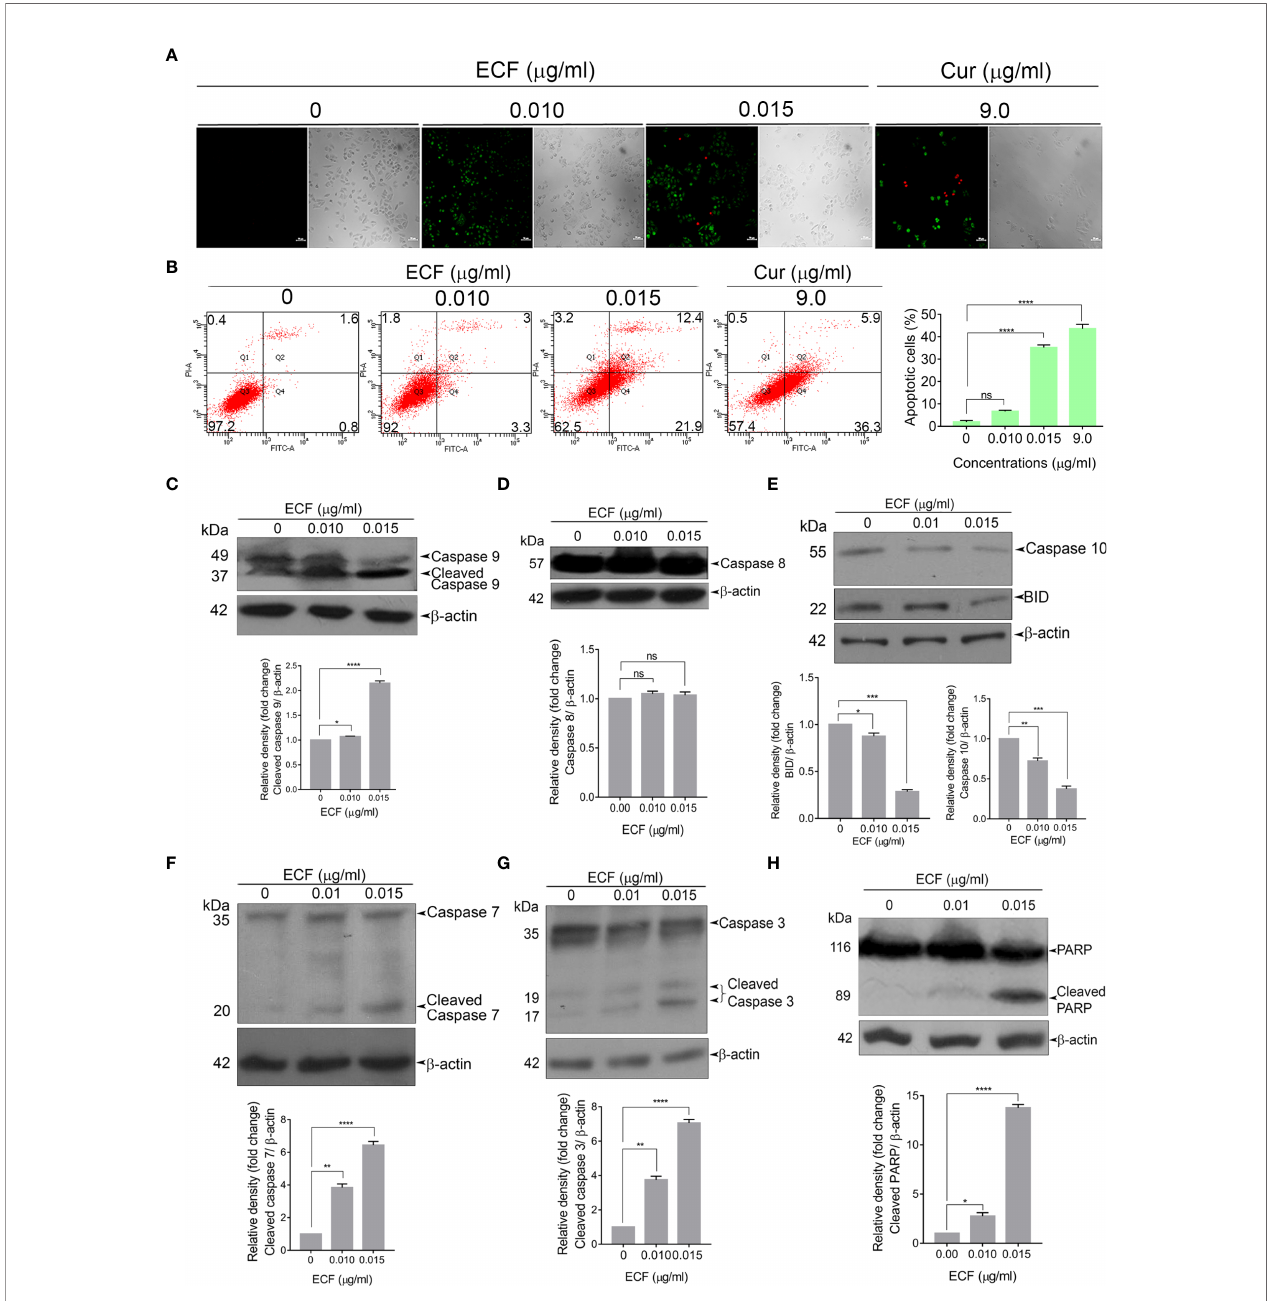
FIGURE 2 | ECF triggers apoptotic mode of cell death in melanoma (A, B) ECF induces apoptosis in A375 cells as assessed by Annexin/PI staining, and was quantitated by FACS analysis. (C – H) ECF potentiates the activation of caspases and cleavage of PARP in A375 cells as analyzed by immunoblotting. Data are representative of three independent experiments (Mean±SEM) and P-values are calculated using one way ANOVA. ****P ≤ 0.0001, ***P ≤ 0.001, **P ≤ 0.01, *P ≤ 0.1and ns ≥